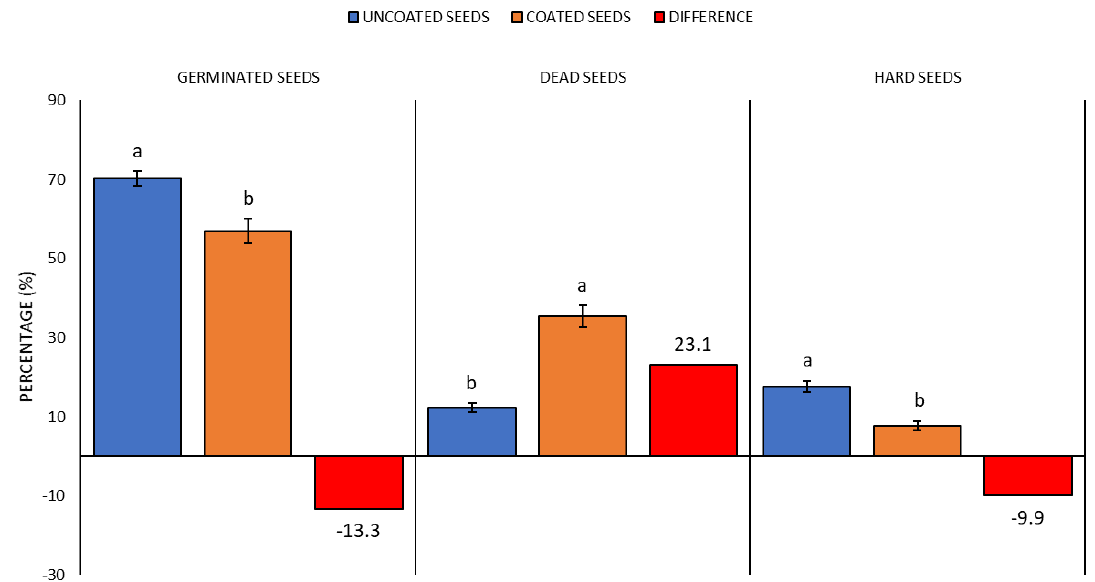
Figure 2. Comparison of germinated, dead and hard seed percentages at PEG treatment—general overview of drought simulation. Average values for all indicator plants for the US (uncoated seeds; n = 160 ± SE; average of all plant species) and CS (coated seeds; n = 160 ± SE; average of all plant species) treatments with the PEG concentration = 0.0 mol; different lowercase letters indicate significant difference (ANOVA post-hoc Tukey’s HSD test; p < 0.05) for the respective parameters between the US and CS groups.